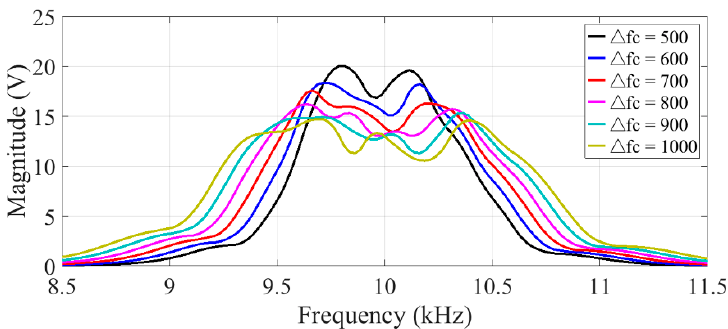
Figure 10. The source DM voltage v DMS spectra of the sawtooth PCFM APF with different frequency deviations.